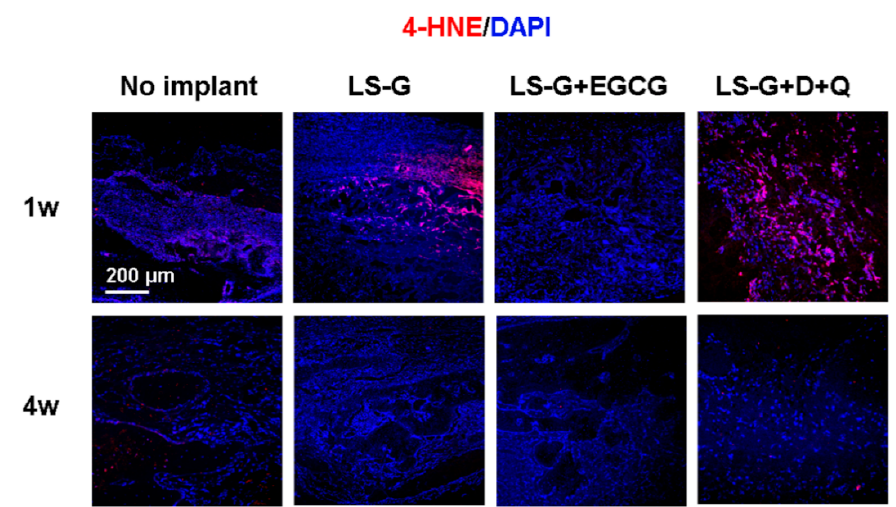
Figure 7. Evaluation of oxidation in bone defects one and four weeks after surgery. Bone defects stained with 4-HNE antibodies (for detecting oxidation). D, Dasatinib; Q, Quercetin; LS-G, implantation of LPS-sustained gelatin sponges in bone defects; LS-G + EGCG, implantation of LS-Gs chemically modified with EGCG in bone defects; LS-G + D + Q, oral administration of D + Q with implantation of LS-Gs in bone defects.